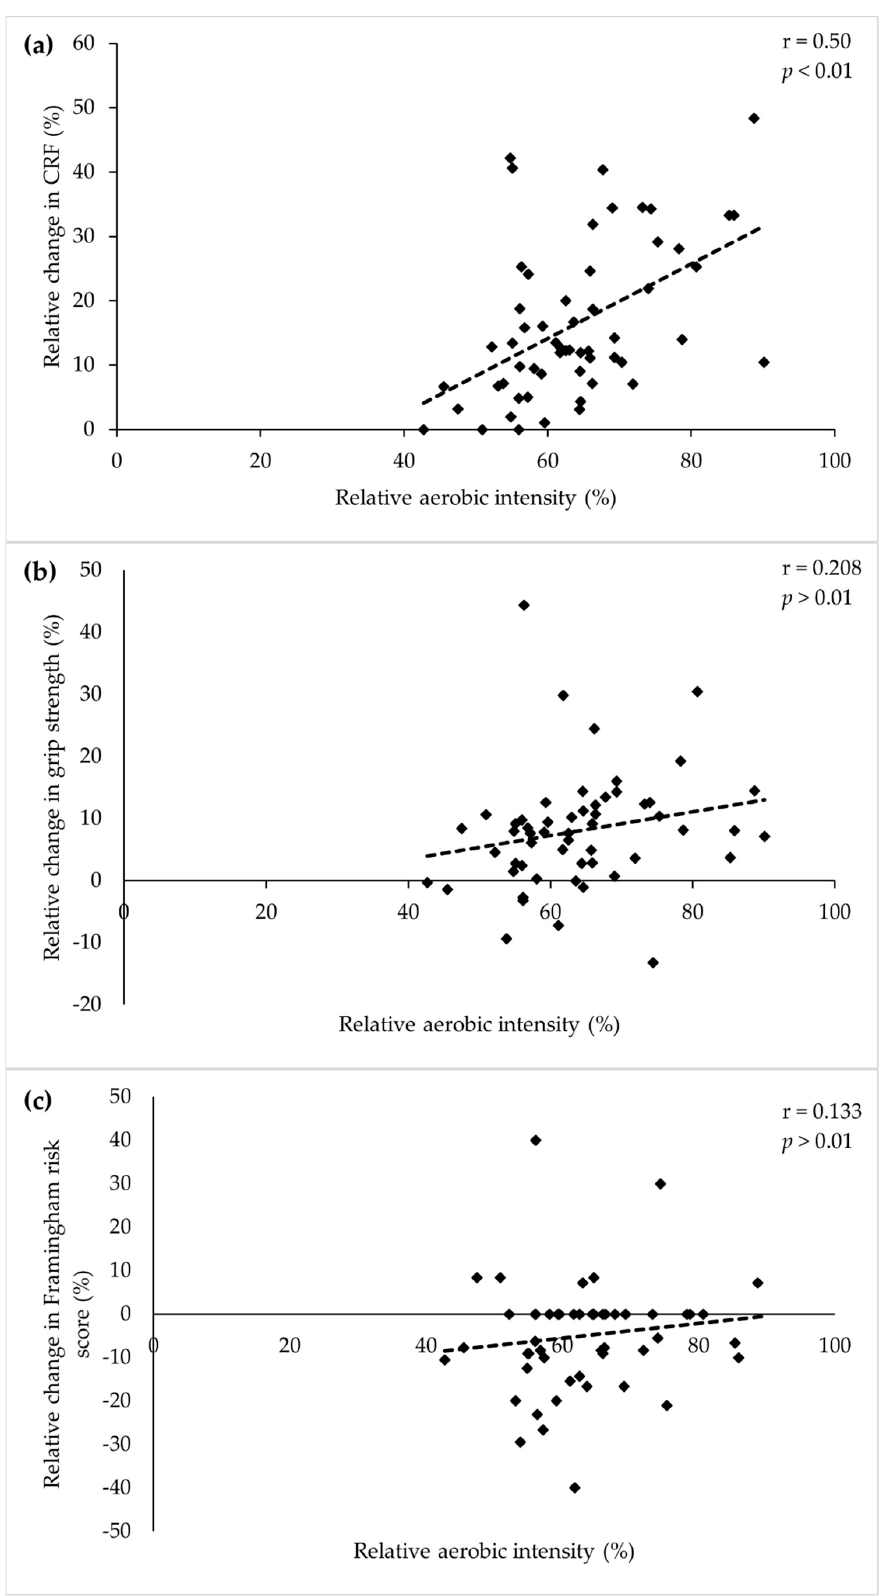
Figure 2. Correlation between mean relative (to initial CRF) aerobic exercise intensity prescribed during the cardiac rehabilitation program and percentage change in: ( a ) cardiorespiratory fitness; ( b ) grip strength; ( c ) Framingham risk score.